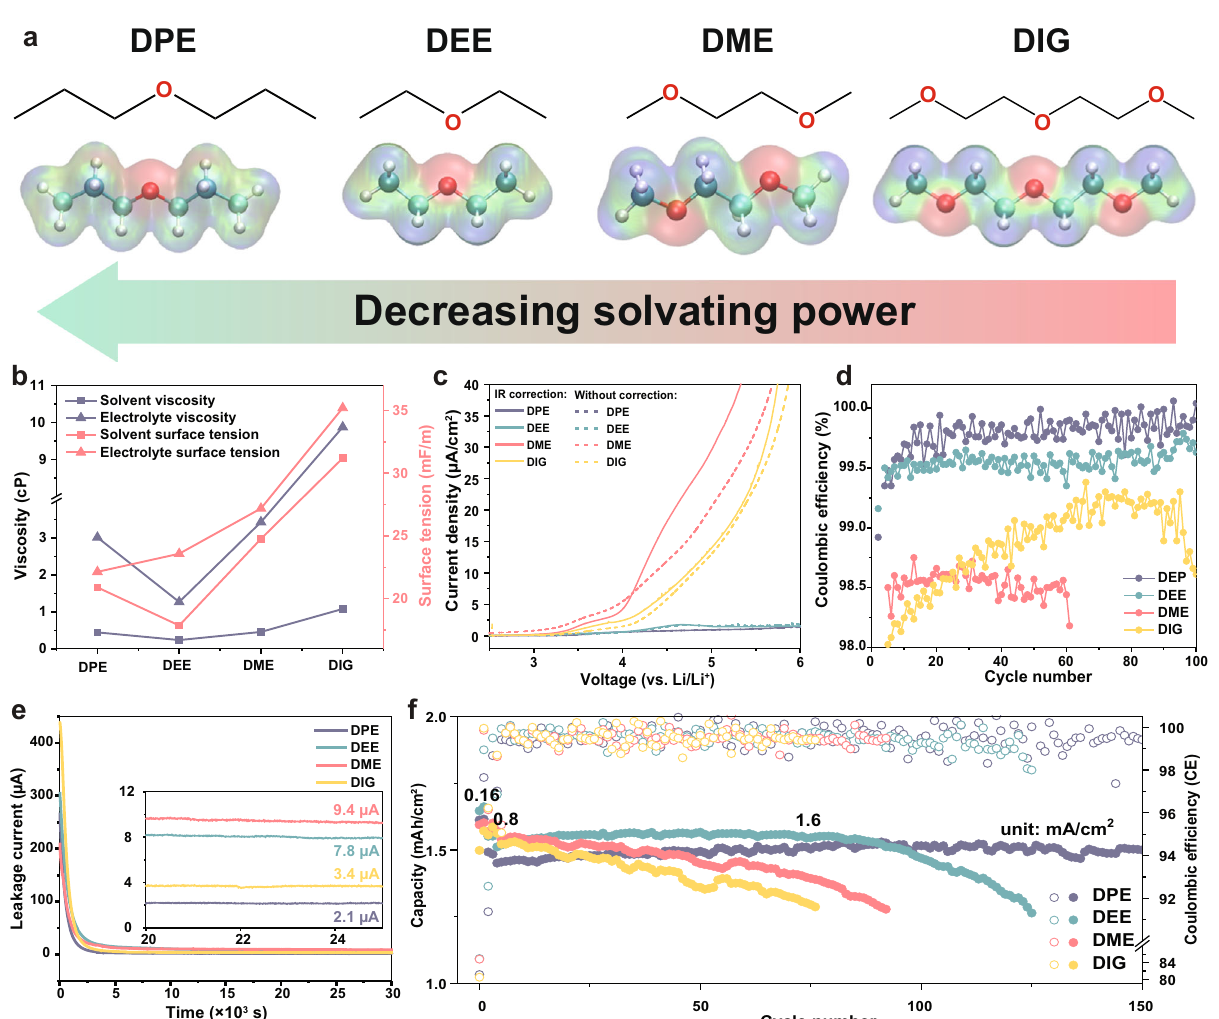
d Coulombic ef fi ciencies of Li||NCM811 coin cells cycled between 2.8 and 4.3V at 0.48mA/cm 2 . Cathode loading is around 8.21mg/cm 2 . e Chronoamperometry testing of Li||NCM811 coin cells at 4.3V. f Long-term cycling performance of Li|| NCM811 coin cells at 1.6 mAh/cm 2 . Two formation cycles at 0.16 and 0.8mA/cm 2 were